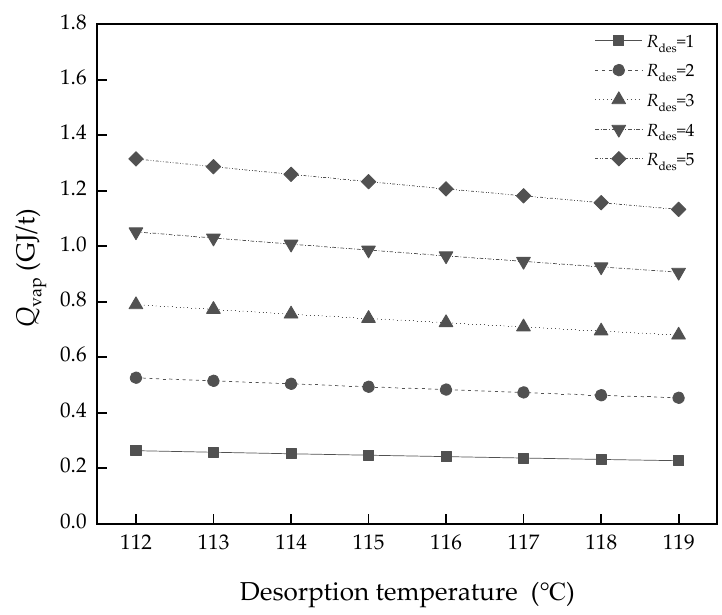
Figure 12. The difference of Q vap with desorption temperature variation in different R des.